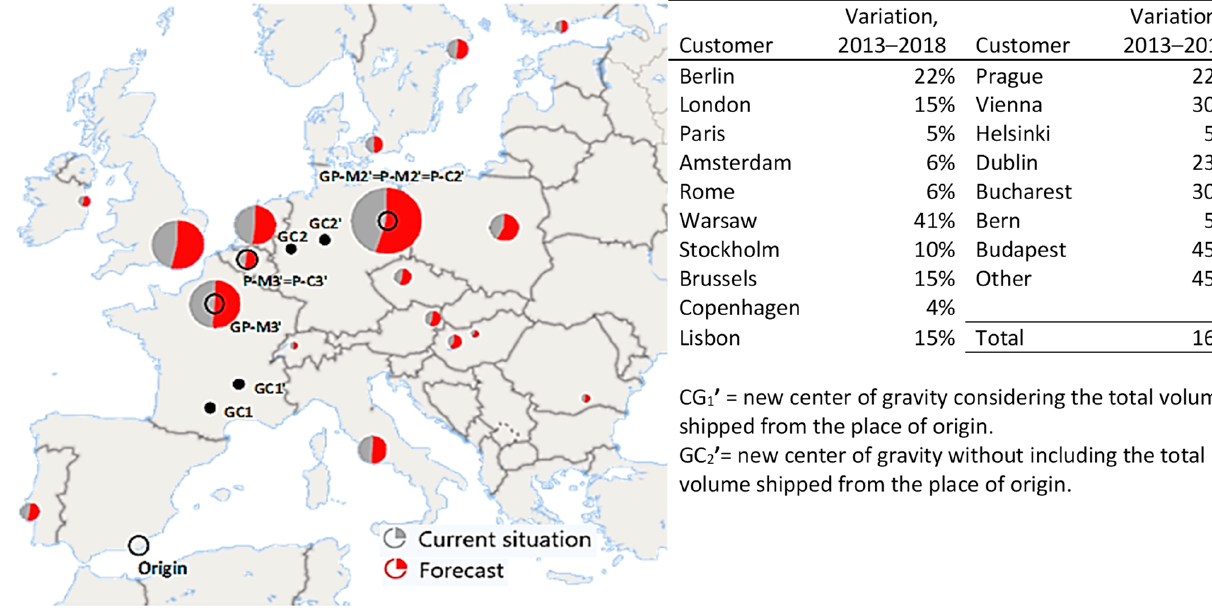
Figure 6. Summary of results applying variations in demand to the gravity p-median (GP-M’), p-median (P-M’), and p-center models (P-C’) for p = 3. Source: own elaboration using the [1] data.